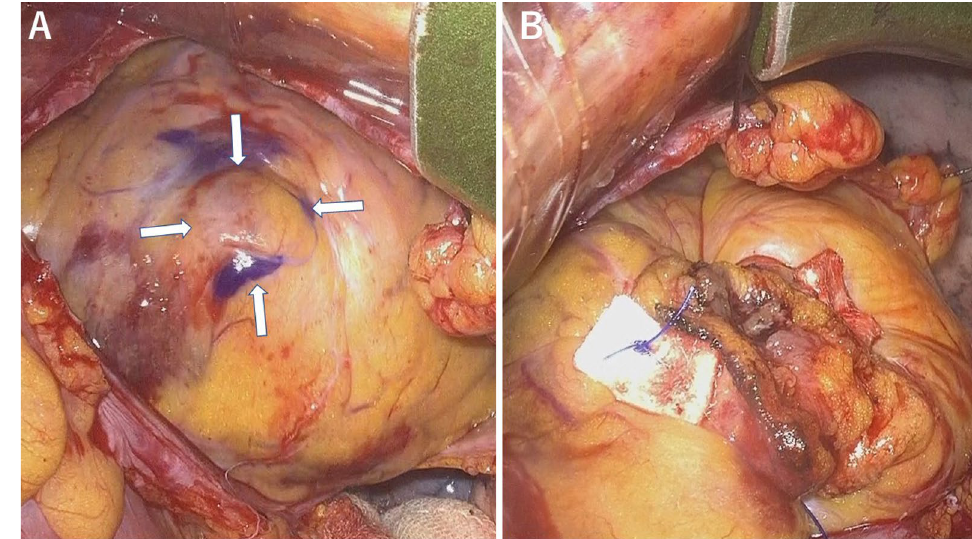
Fig. 3 Intraoperative images. a Left ventricle aneurysm at apex: allows. b Resected and sutured